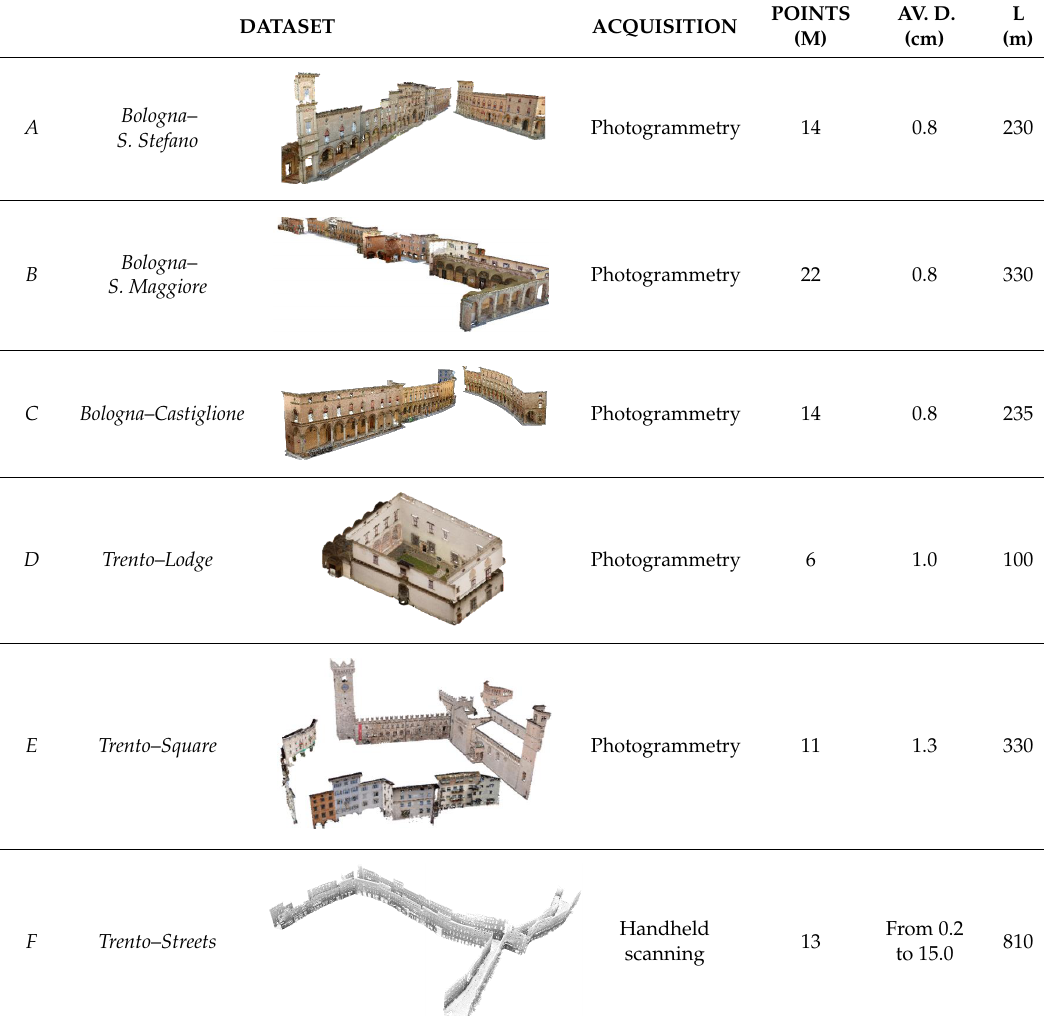
Table 1. Datasets considered in the presented work to validate the pre-trained model and the generalisation method (Av. D. = average distance between points, L= length of the facades).